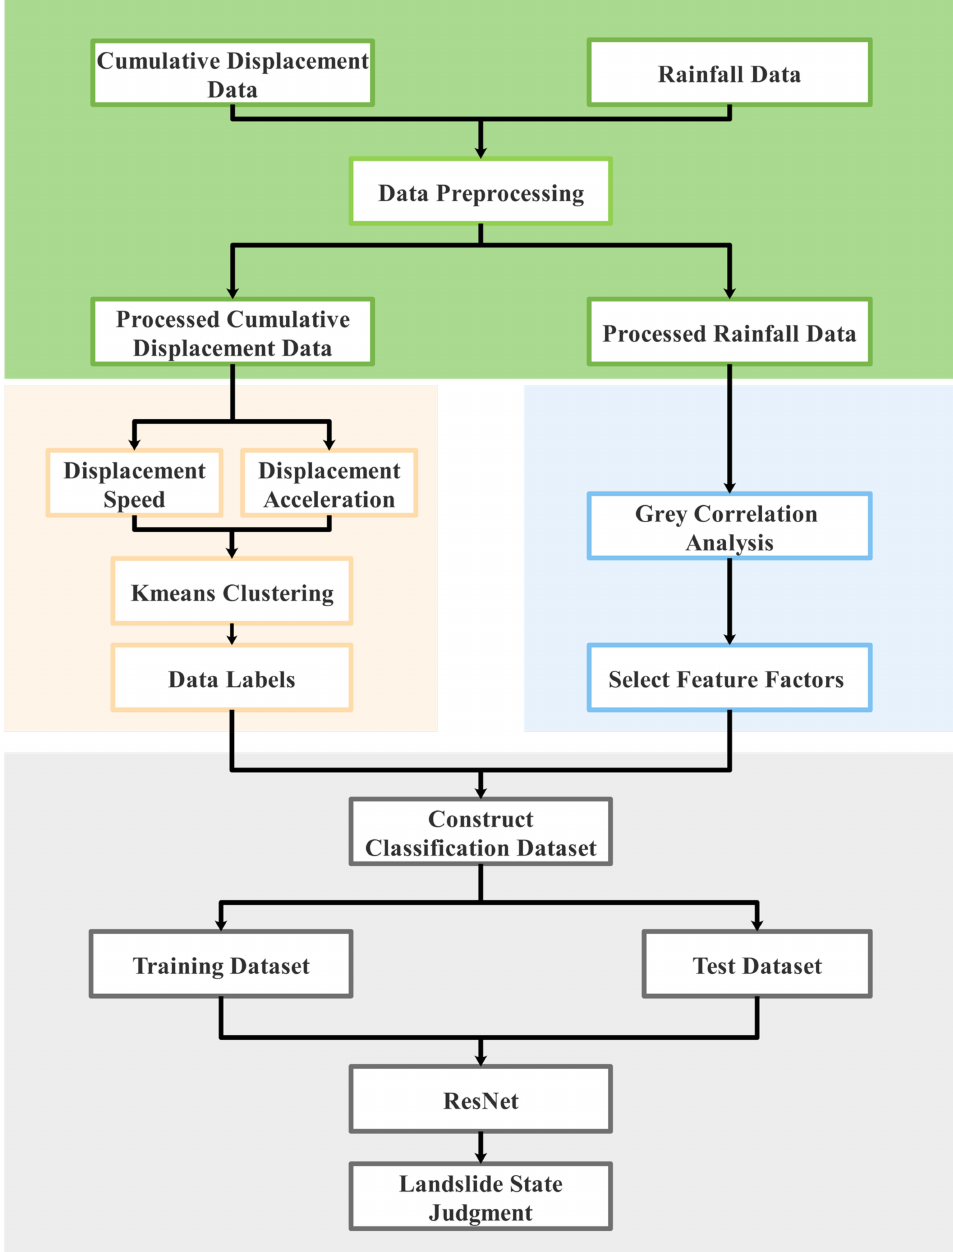
Figure 3. Flowchart of the proposed